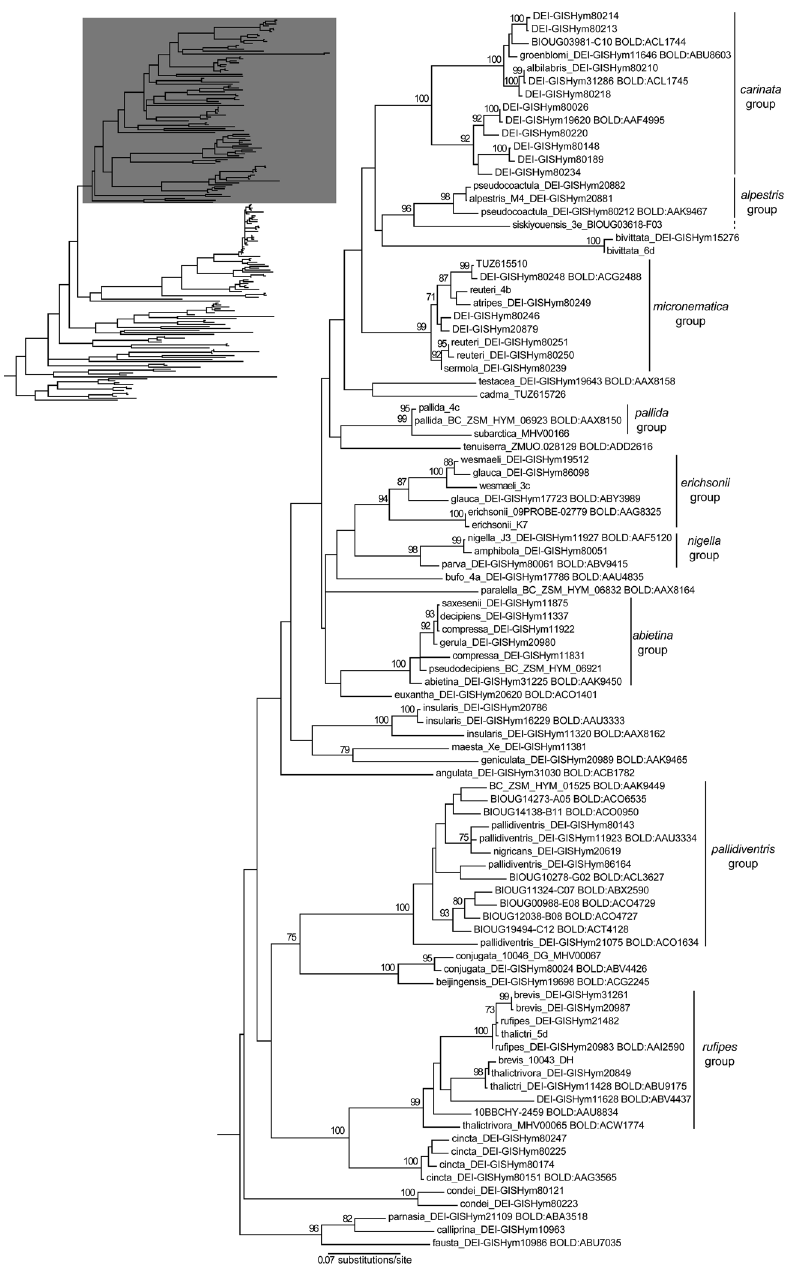
Figure 5. Part of the maximum likelihood tree shown in Fig. 3. Numbers above branches show bootstrap proportions (%). Support values for weakly supported branches (BP<70) are not shown. BIN numbers (BOLD:XXXXXXX) referred to in the text are shown for representative specimens. Outline of the full tree is shown upper left, with the part shown here highlighted. The scale bar shows the number of estimated substitutions per nucleotide